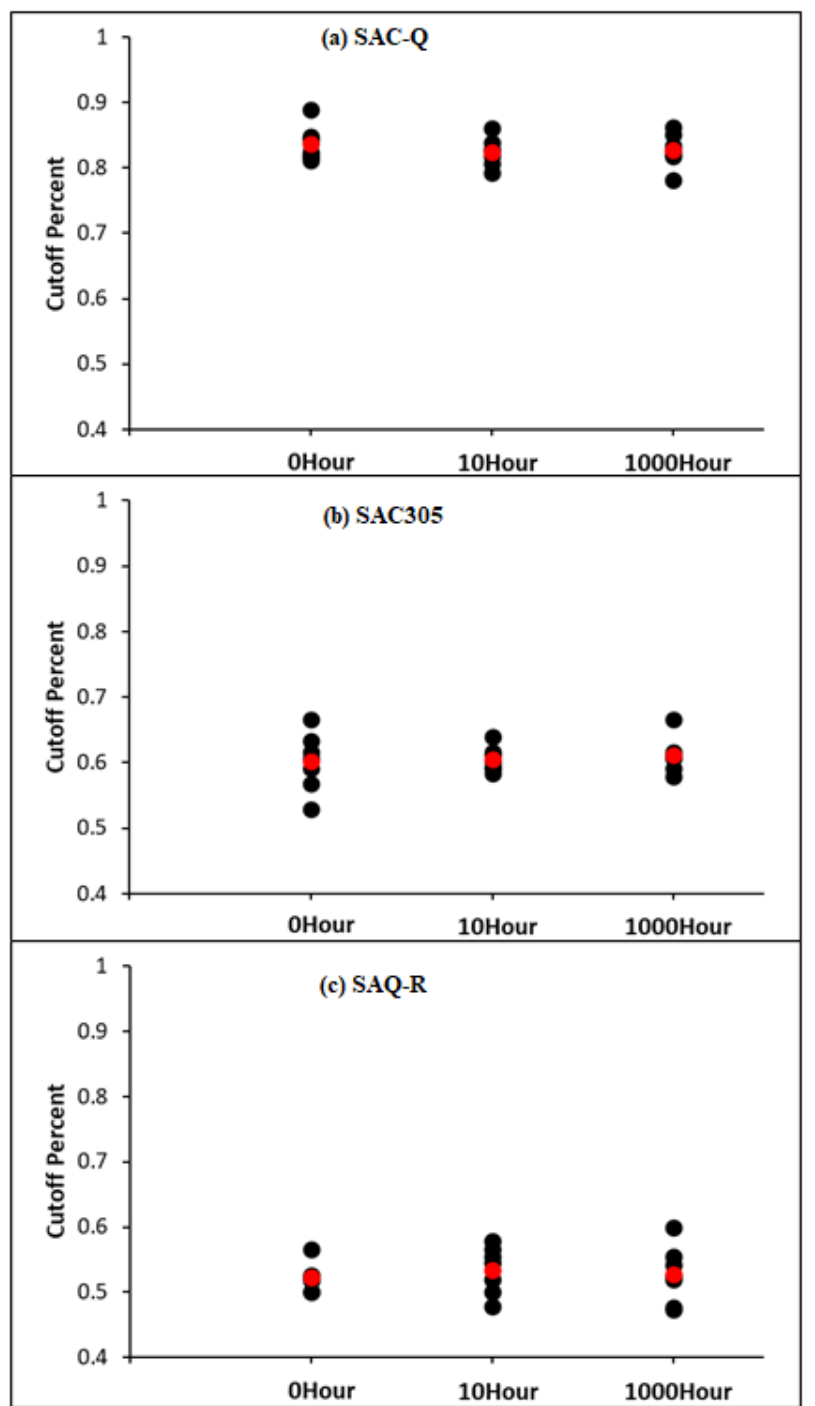
Figure 16. Cut-Off summary for non-aged, 10, and 1000 h aged for ( a ) SAC-Q, ( b ) SAC305, and ( c ) SAC-R individual solder joint.